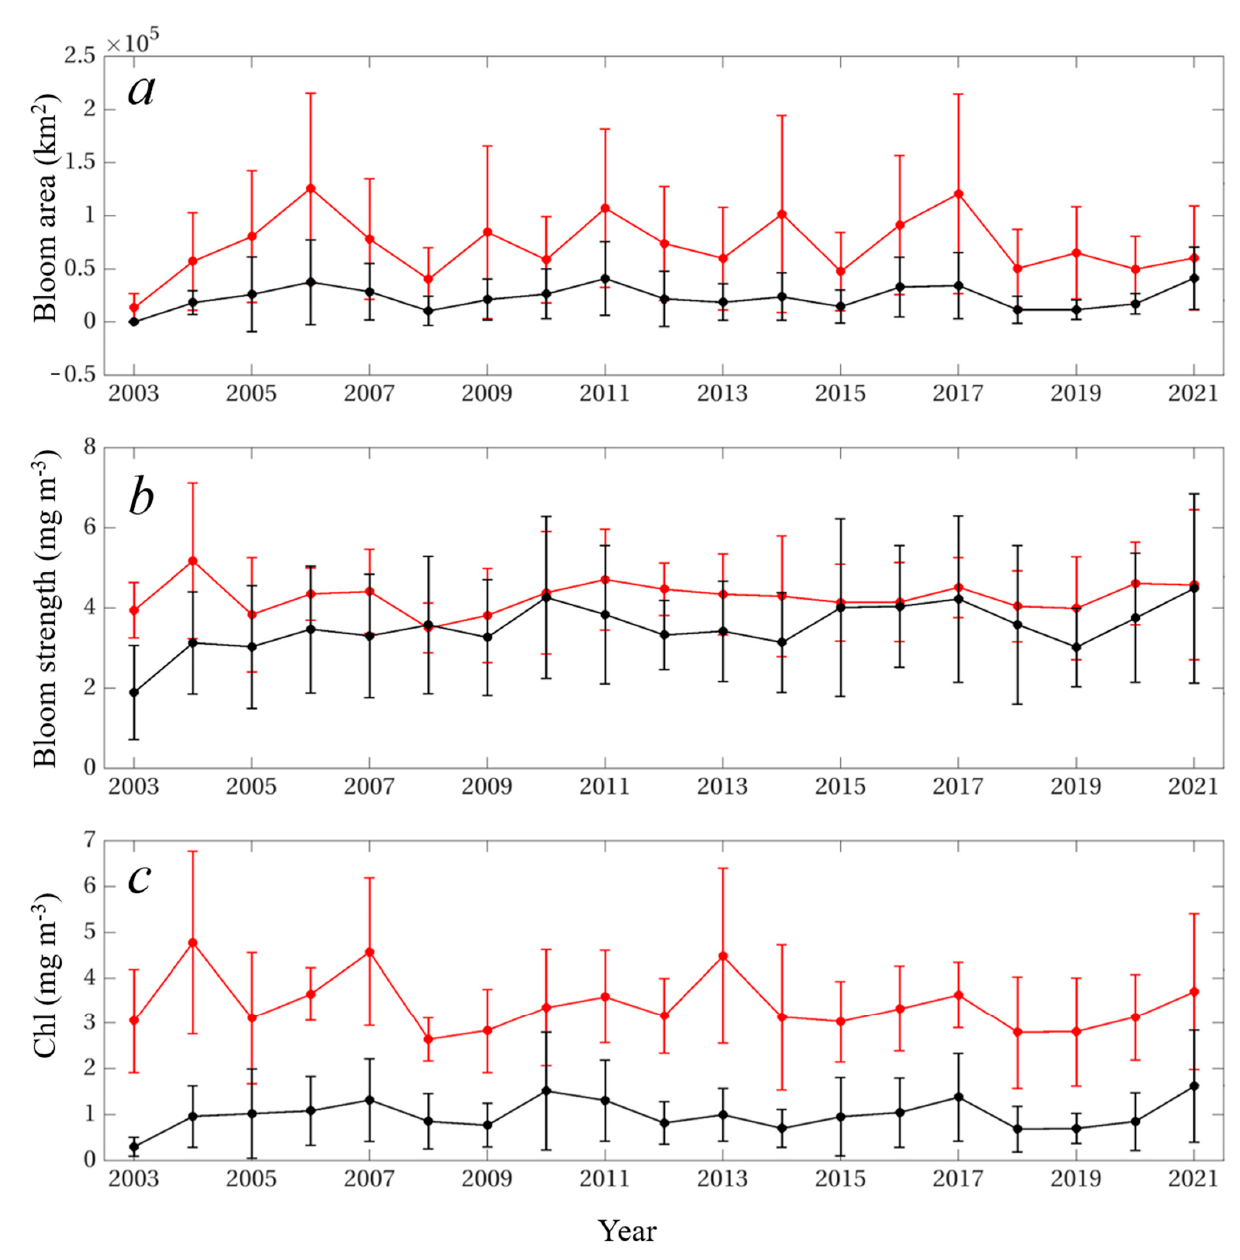
Figure 4. Interannual variations of the phytoplankton bloom areas ( a ), bloom strength ( b ), and Chl ( c ) between 2002 and 2021 in the Ross Sea. Note that the black and red curves are derived using the NASA standard algorithm and the locally tuned Rrs667-based algorithm, respectively, and the error bar associated refers to one standard deviation. The bloom strength was quantified for pixels with Chl ≥ 2 mg m − 3 .